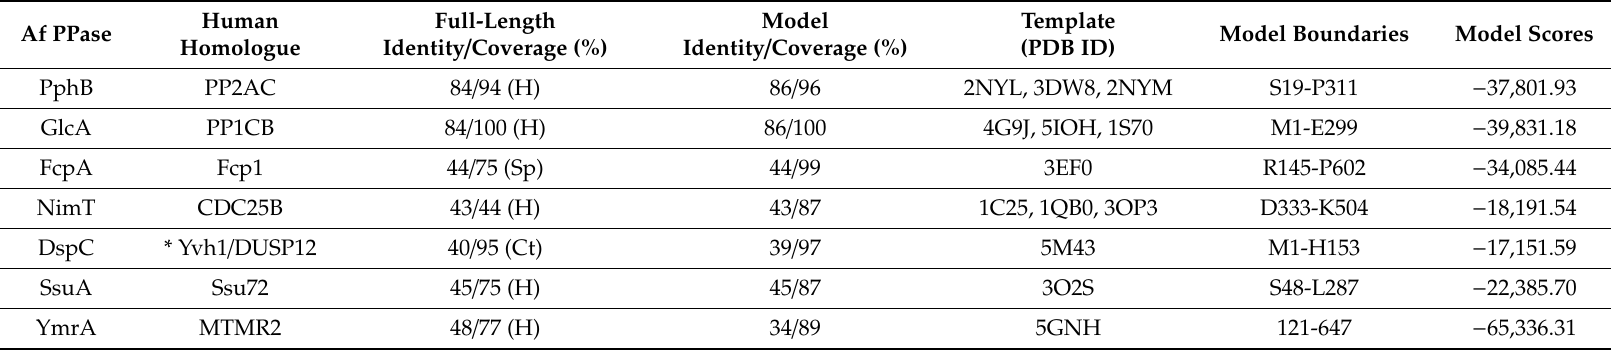
Table 1. Aspergillus fumigatus phosphatases (AfPPases) analysed in this study. The human homologues are indicated. Protein Data Bank (PDB) IDs are template structures used for homology model building. Identity and coverage for both the full length and the sequences used in the models were calculated from the templates sequences as marked. H: Human, Ct: Chaetomium thermophilum , Sp: Schizosaccharomyces pombe . Domain boundaries are the ones used for the homology model building. * dual-specificity phosphatase Yvh1 is the Sp homologue of the dual-specificity phosphatase DspC, Dual-specificity phosphatase DUSP12 is the human homologue. The model scores correspond to the Modeller objective function score (discrete optimised protein energy (DOPE) score) provided by Modeller [20] for the best model. PP2AC: catalytic domain of protein phosphatase 2A, PP1CB: catalytic domain of protein phosphatase 1 β , Fcp1: TFIIF-stimulated CTD phosphatase